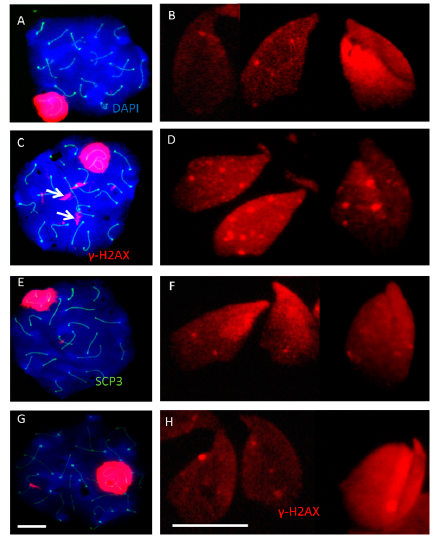
Figure 2. Representative images from non-irradiated meiotic spreads of pachytene spermatocytes and elongated spermatids stained for γ -H2AX (red) from wild type ( A , B ); RAD54/RAD54B double knockout mice ( C , D ); Severe Combined Immunodeficiency (SCID) mice ( E , F ) and PARP1 inhibitor (DPQ)-treated mice ( G , H ). In pachytene, spermatocytes of Rad54/Rad54B dko mice more large (L) foci can be seen (arrows, C ), more foci in elongated spermatids are also shown in addition to the staining background ( D ). Scale bars: 10 µm.